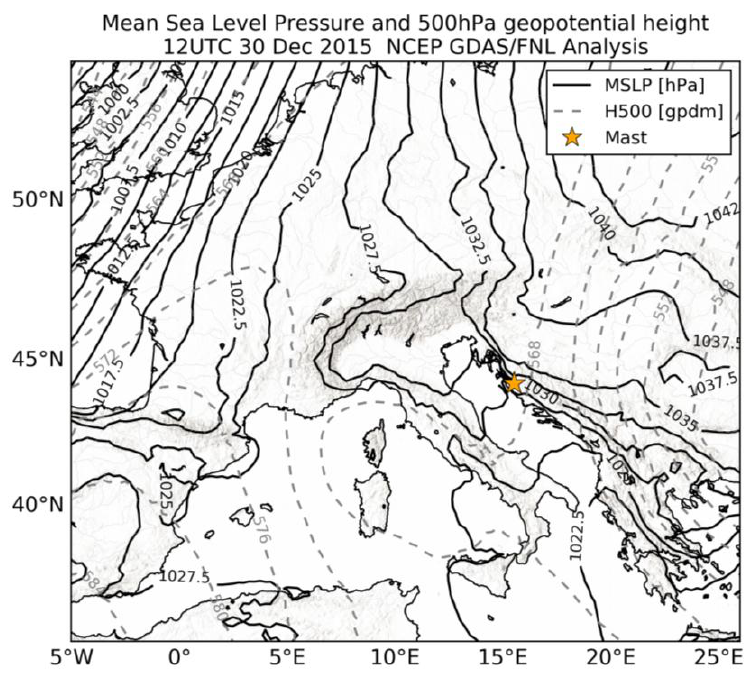
Figure 6. As with Figure 3, but for B09 (DA); 12 UTC on 30 December 2015.